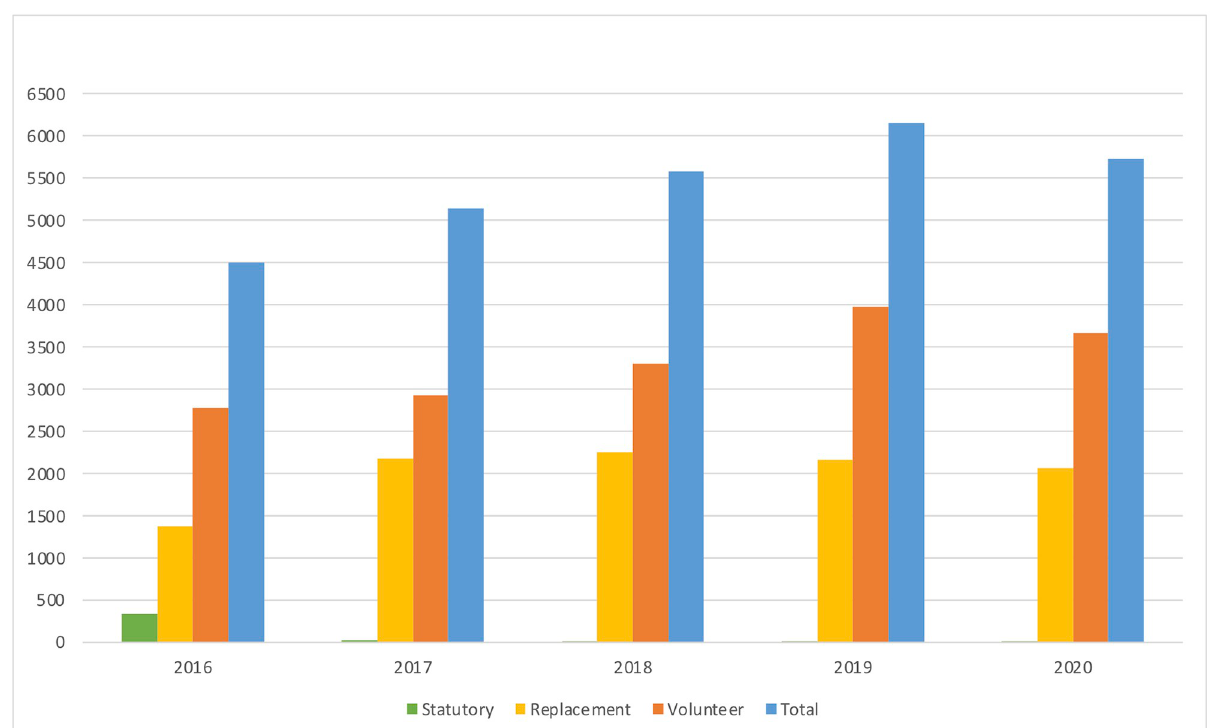
For the 3,836 patients anticipated to require a transfusion, a crossmatch was ordered 13,324 times (average, 3.47 crossmatch/patient). Each crossmatch request was accompanied by the number of units needed, which was in a median of 2 units per request (IQR 1–2). The mean age of the recipients was 31.1 + 23.1 years, and 64.6% of them were women (male:female ratio, 0.55:1). Most recipients (83.7%) were Saudis, and the most frequent (47.6%) blood type requested was O positive. The most frequently ordered blood components were packed